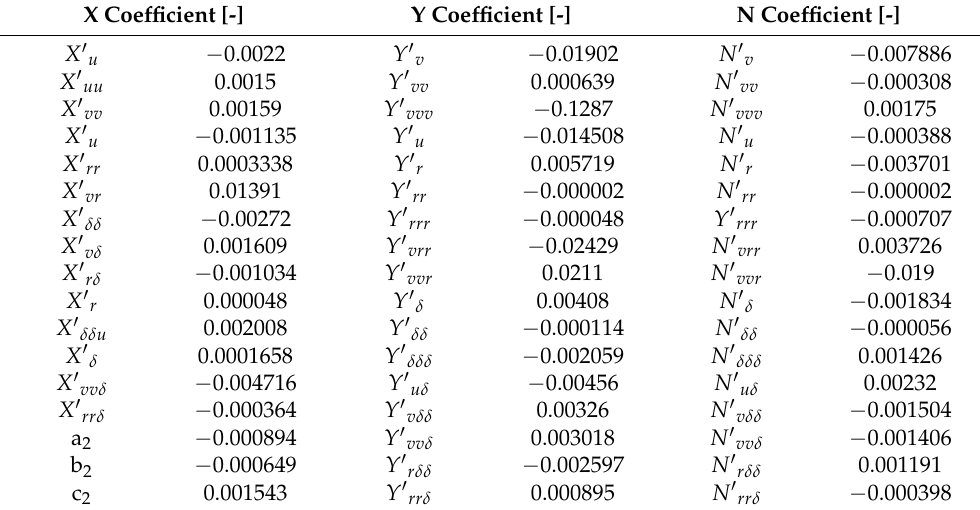
Table 3. Hydrodynamic derivatives.